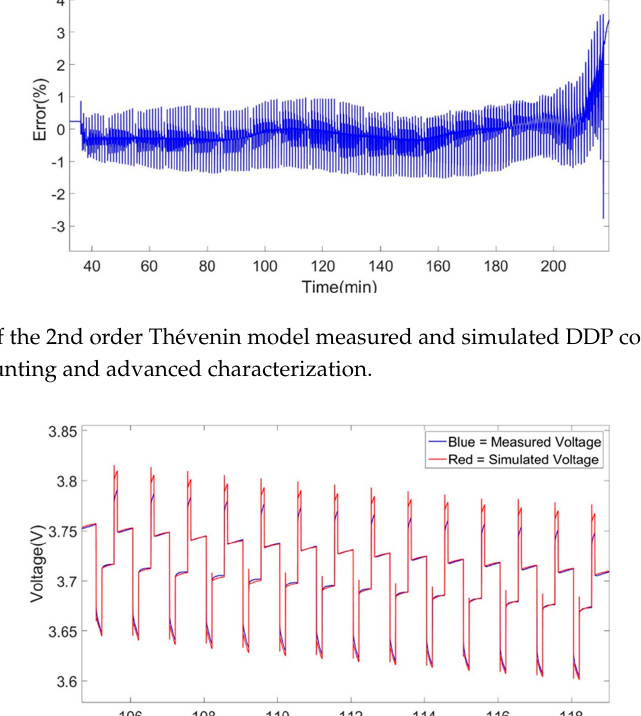
Figure 18. Dynamic behavior of the 2nd order Thévenin model measured and simulated DDP comparison at 25 °C with Coulomb counting and advanced characterization. Table 7. Results of the models where the SoC window is less than the proposed error.